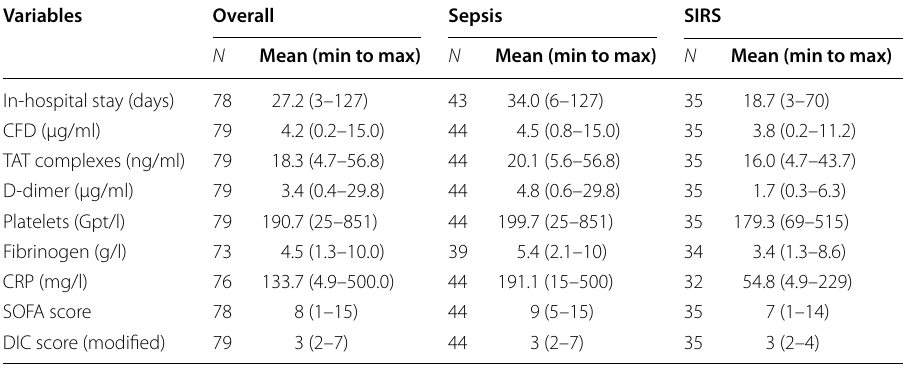
Table 2 Patient characteristics and scores after diagnosis of sepsis or SIRS in the investigated study